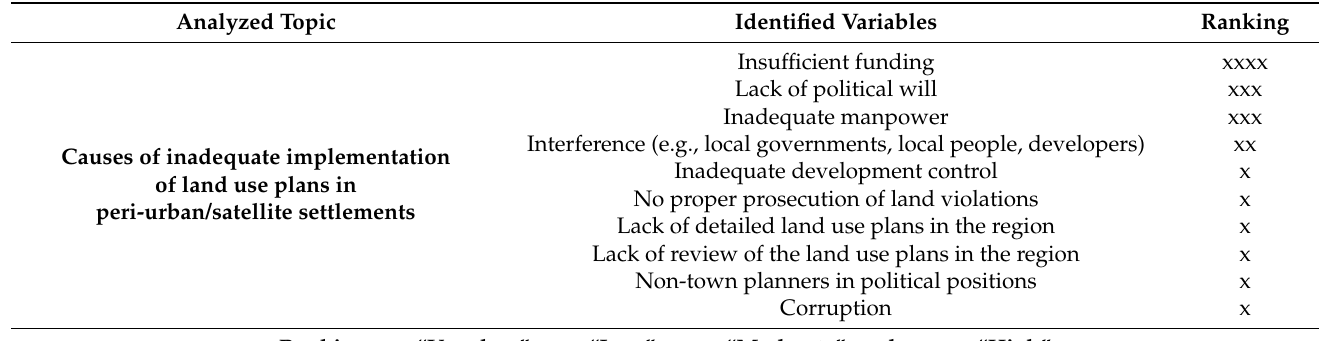
Table 6. Causes of inadequate implementation of land use plans based on a survey of experts.